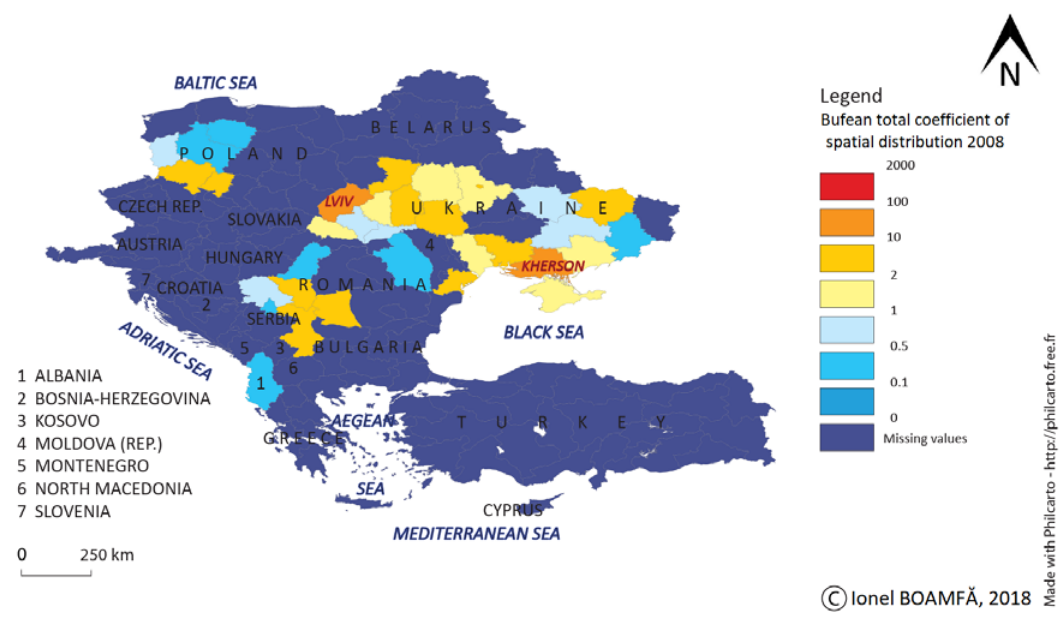
Figur e 8 . G eographical repartition of the anthroponym Bufean. Coef. of spatial distribution